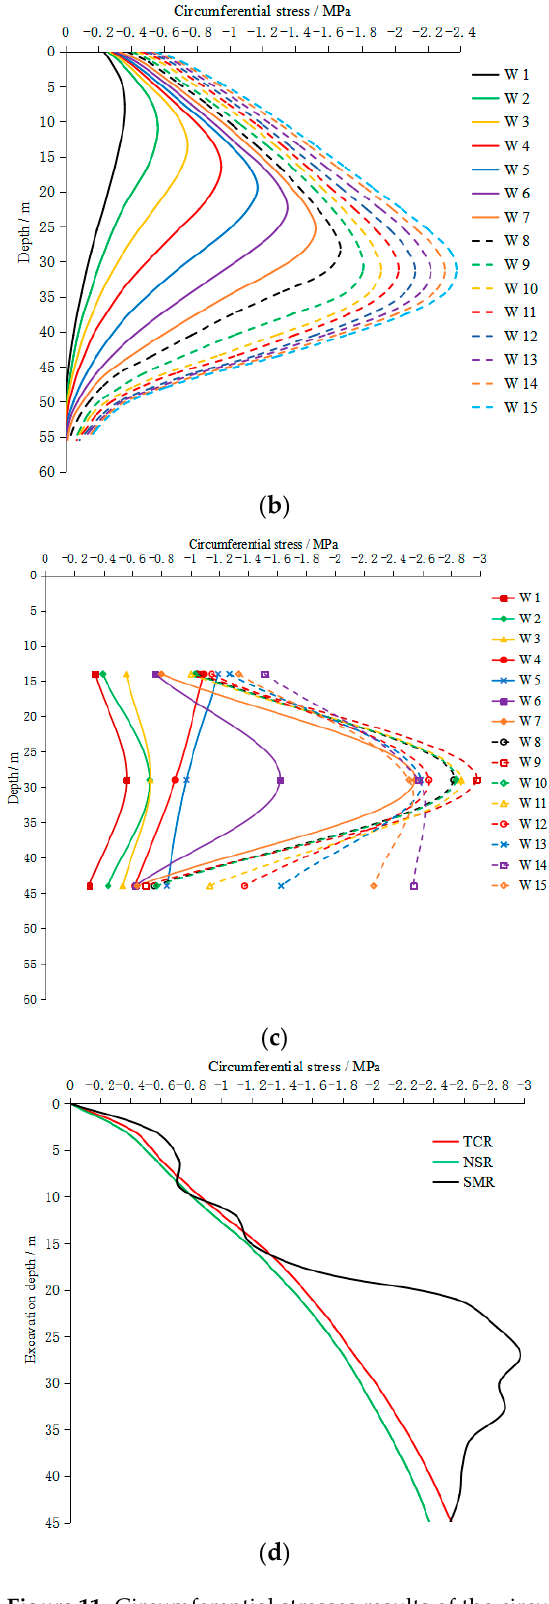
Figure 11. Circumferential stresses results of the circular diaphragm wall at Point A. ( a ) Variation of circumferential stresses obtained by CCSTCM with depth in different working conditions. ( b ) Variation of circumferential stresses obtained by FENSM with depth in different working conditions. ( c ) Variation of circumferential stresses obtained by site monitoring with depth in